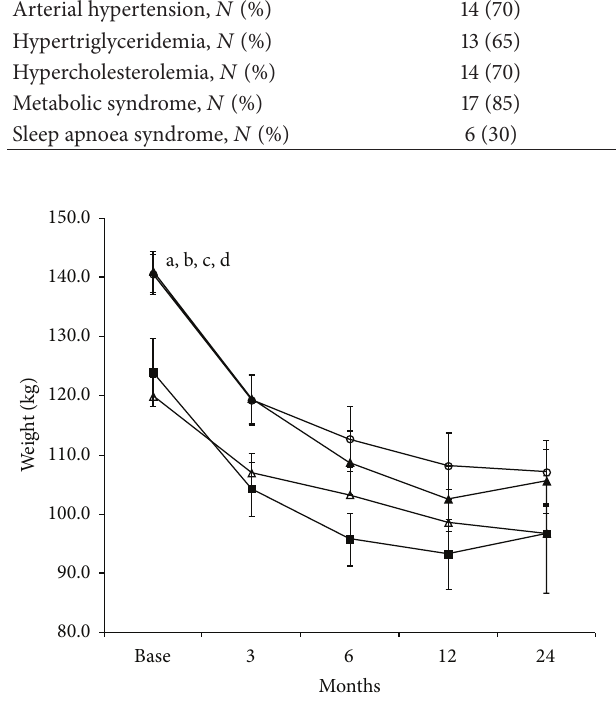
Figure 2: Changes in weight (mean ± SEM) induced by the different types of bariatric surgery procedures in obese diabetic patients. ( Δ ) gastric banding (GB); (o) calibrated gastrectomy type Mason (CGMa); ( 󳵳 ) sleeve gastrectomy (SG); ( ◼ ) Roux-en-Y gastric bypass (RYGB). a 𝑃 < 0.05 CGMa versus GB; b 𝑃 < 0.05 SG versus GB, c 𝑃 < 0.05 CGMa versus RYGB, d 𝑃 < 0.05 SG versus